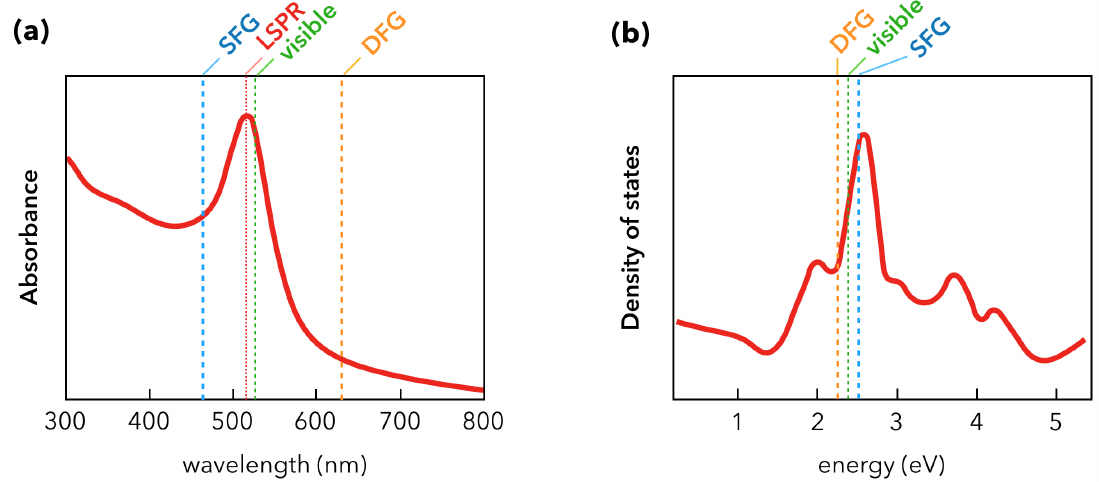
Figure 5. Electronic and optical properties of gold. ( a ) Localized surface plasmon resonance (LSPR) of AuNPs in aqueous solution displayed as a function of the incident wavelength as measured by UV-Visible spectroscopy. ( b ) Scheme of the density of electronic states (DOS) of bulk gold as a function of the incident energy. Pictures ( a , b ) are tagged with the SFG and DFG energy for an incident visible beam of 532 nm wavelength and an incident IR beam of 3 µm. In these conditions, it is clear that although the SFG/DFG/visible beams are located near the LSPR maximum in ( a ), the contribution of the gold DOS (main s − d interband electronic transition located at 487 nm) in ( b ) may interfere and drastically hamper a possible LSPR-SFG